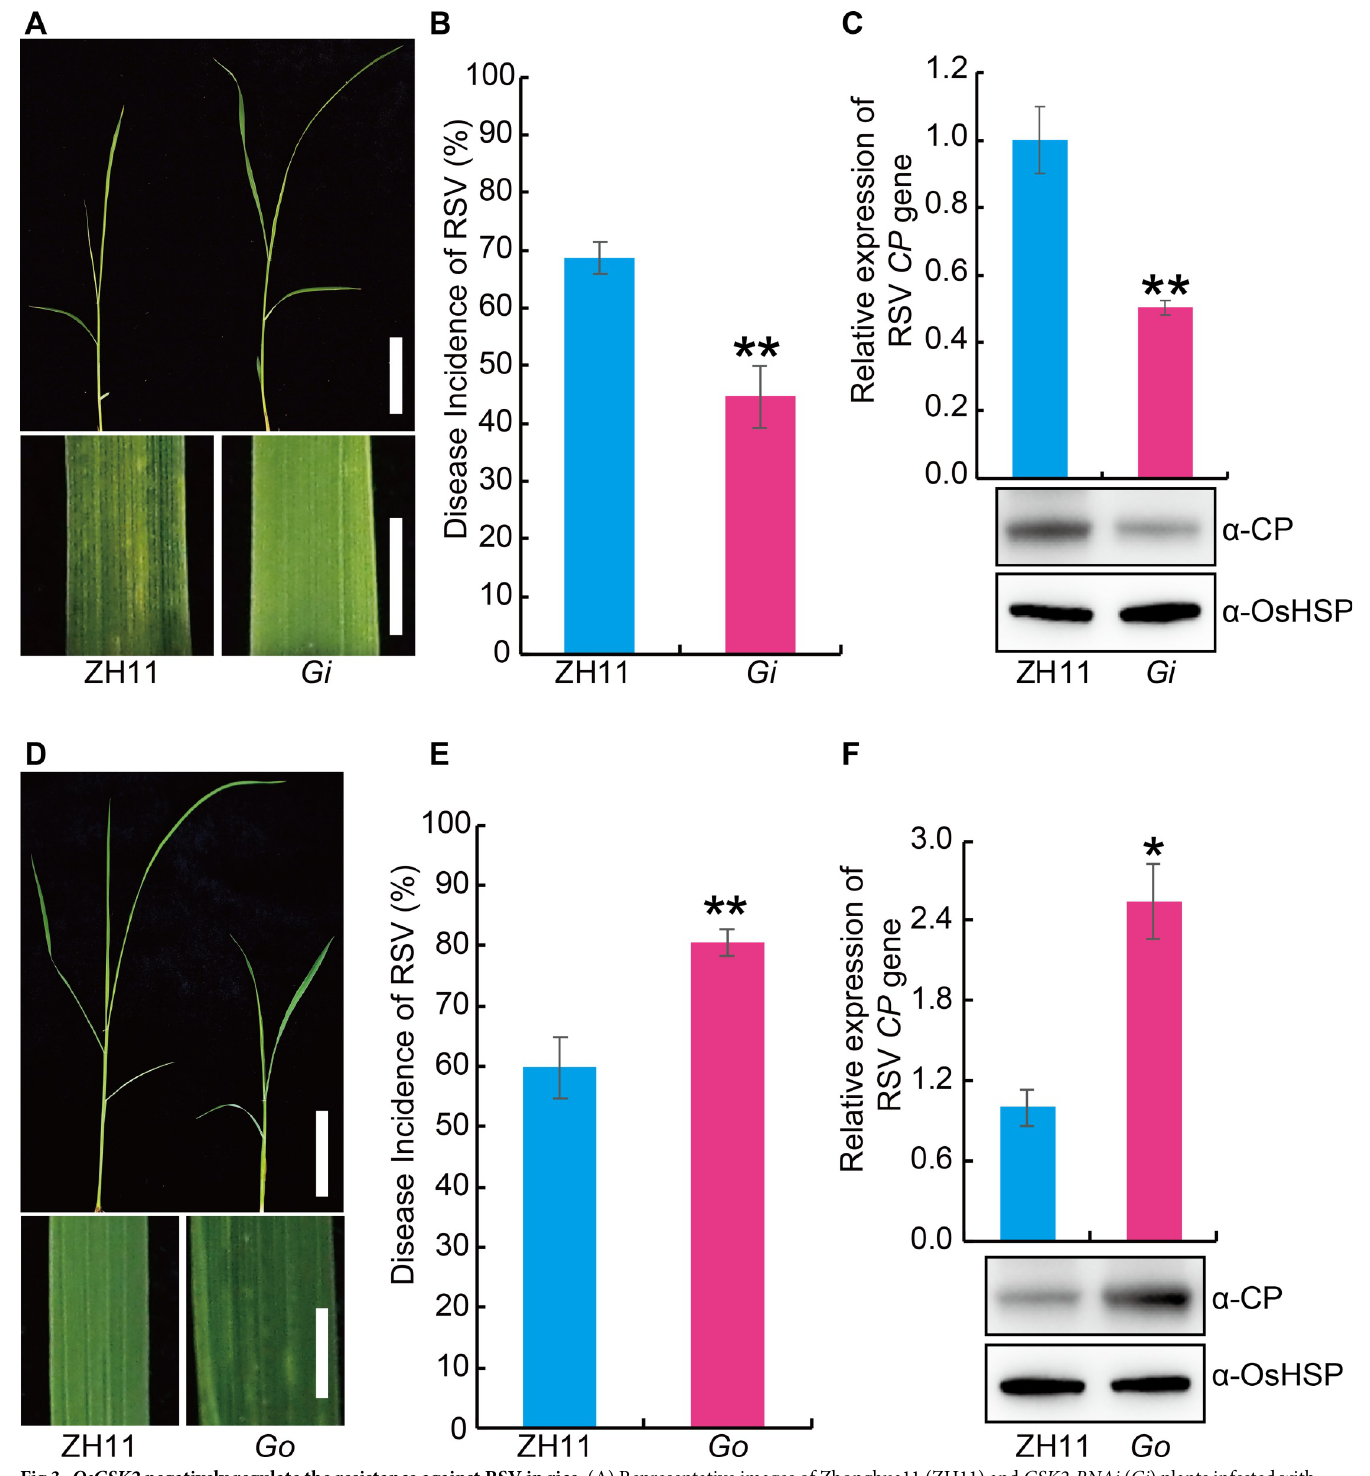
Fig 3. OsGSK2 negatively regulate the resistance against RSV in rice. (A) Representative images of Zhonghua11 (ZH11) and GSK2-RNAi ( Gi ) plants infested with RSV-carrying SBPH. Bar = 5 cm (top). Bar = 3 mm (bottom). (B) RSV incidence of ZH11 and Gi at 30 dpi with RSV-carrying SBPH. (C) Detection of RSV CP RNA expression levels (upper panel) by quantitative RT–PCR assay and western blot analysis of the RSV coat protein (lower panel) in the RSV-infected plants of ZH11 and Gi , respectively. OsHSP was used as loading control. (D) Representative images of ZH11 and GSK2 overexpressing ( Go ) plants infested with RSV-carrying SBPH. Bar = 5 cm (top). Bar = 3 mm (bottom). (E) RSV incidence of ZH11 and Go at 30 dpi with RSV-carrying SBPH. (F) Detection of RSV CP RNA expression levels (upper